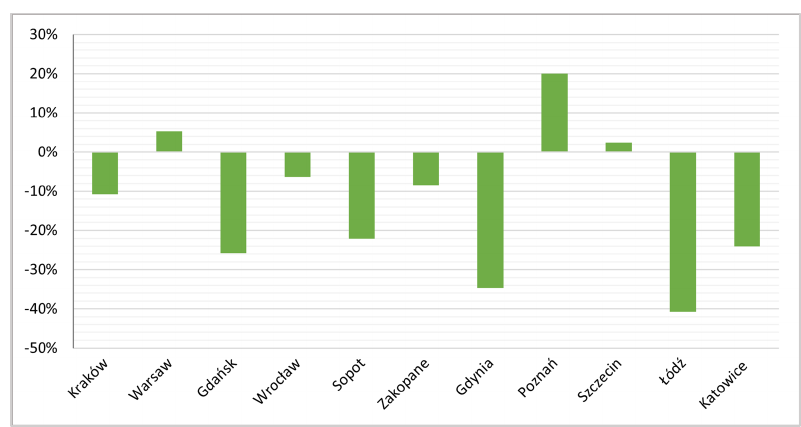
Figure 12. Indices of dynamics of changes in proportion of private rooms, Sept 2019 to Sept 2021.